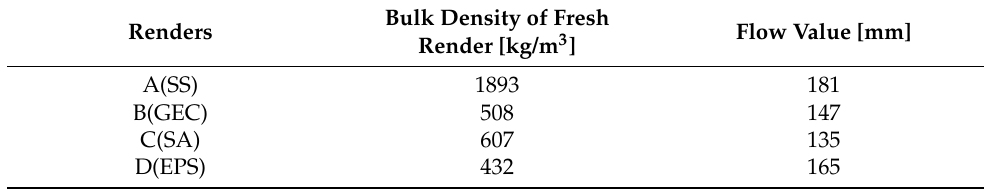
Table 1. Properties of renders at fresh state.